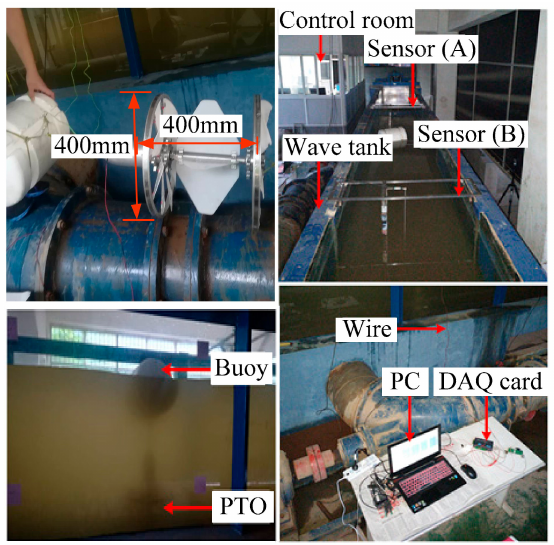
Figure 18. Wave tank test platform.